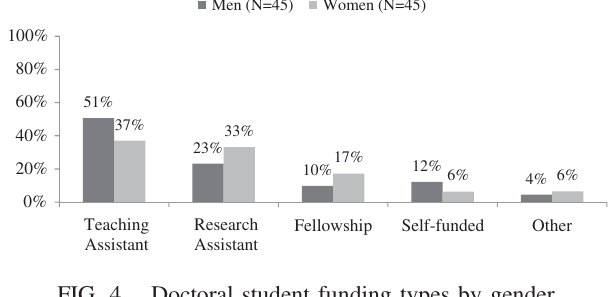
FIG. 4. Doctoral student funding types by